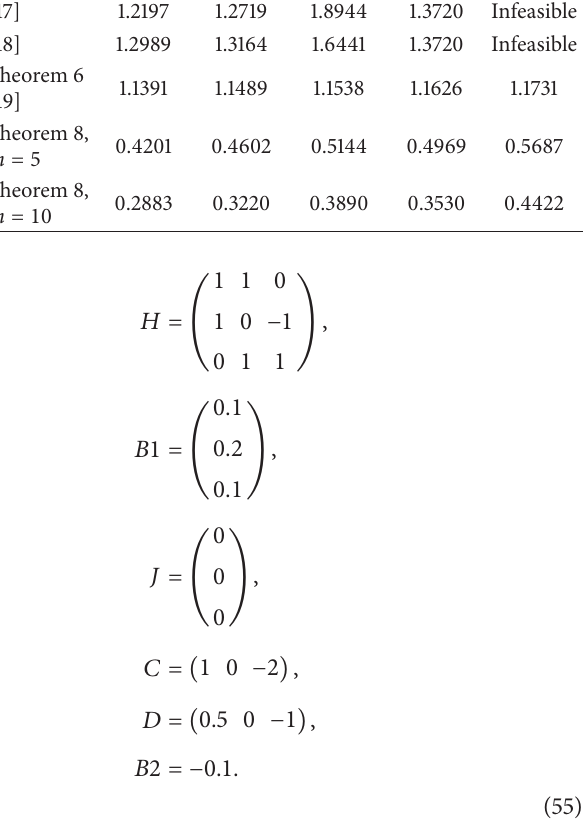
Table 1: The 𝐻 ∞ performance index 𝛾 with different (𝑑 2 ,𝜇) .